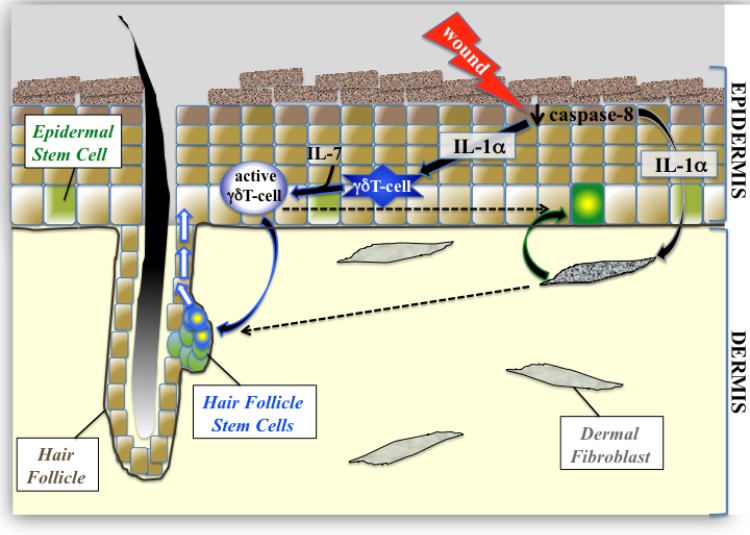
Proposed model of epidermal stem cell proliferation in the caspase-8 conditional knockout model of wound healing.Upon wounding, caspase 8 levels are downregulated causing the release of IL-1α, which can stimulate the proliferation of interfollicular epidermal stem cells (IFE) through its interactions with dermal fibroblasts. This IL-1αmediated epithelial–mesenchymal crosstalk has a milder effect on hair follicle stem cell (HFSC) proliferation. IL-1α and IL-7 cooperate to enhance the proliferation of activated γδT-cells, which preferentially influences HFSC proliferation.